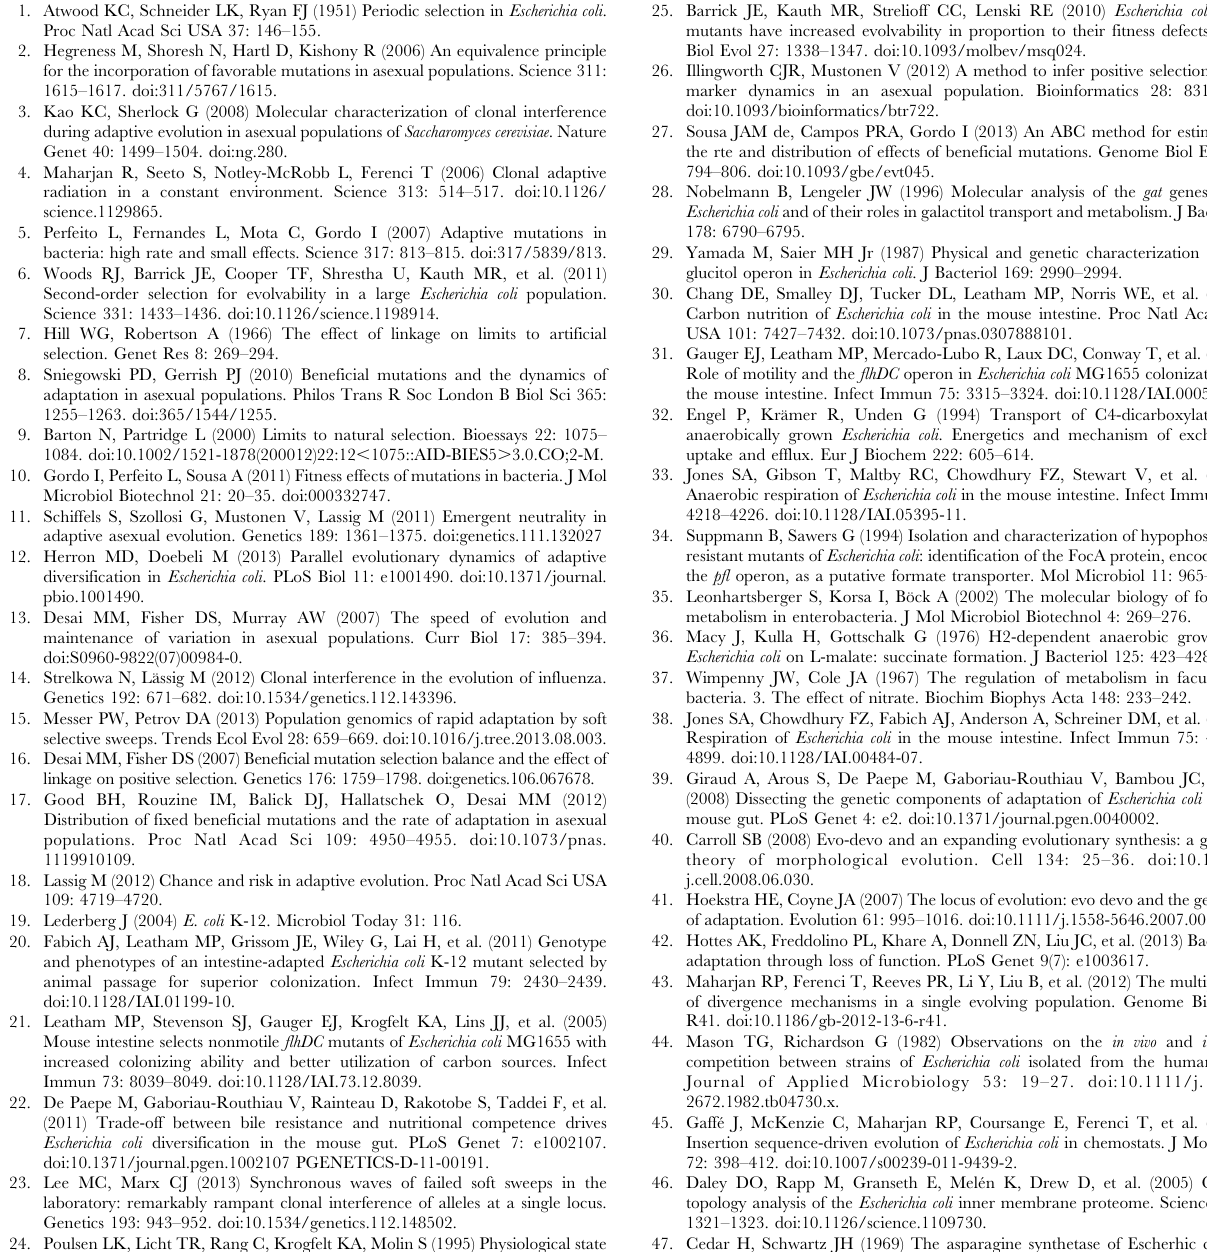
Table S5 Frequencies of newly generated haplotypes along 24 days of evolution of population 1.11 inside the mouse gut. Table S6 Frequencies of newly generated haplotypes along 432 generations of evolution of population 1.12 inside the mouse gut. Table S7 The number and nature of adaptive events across independently evolved populations. Table S8 Oligonucleotide primers used in this